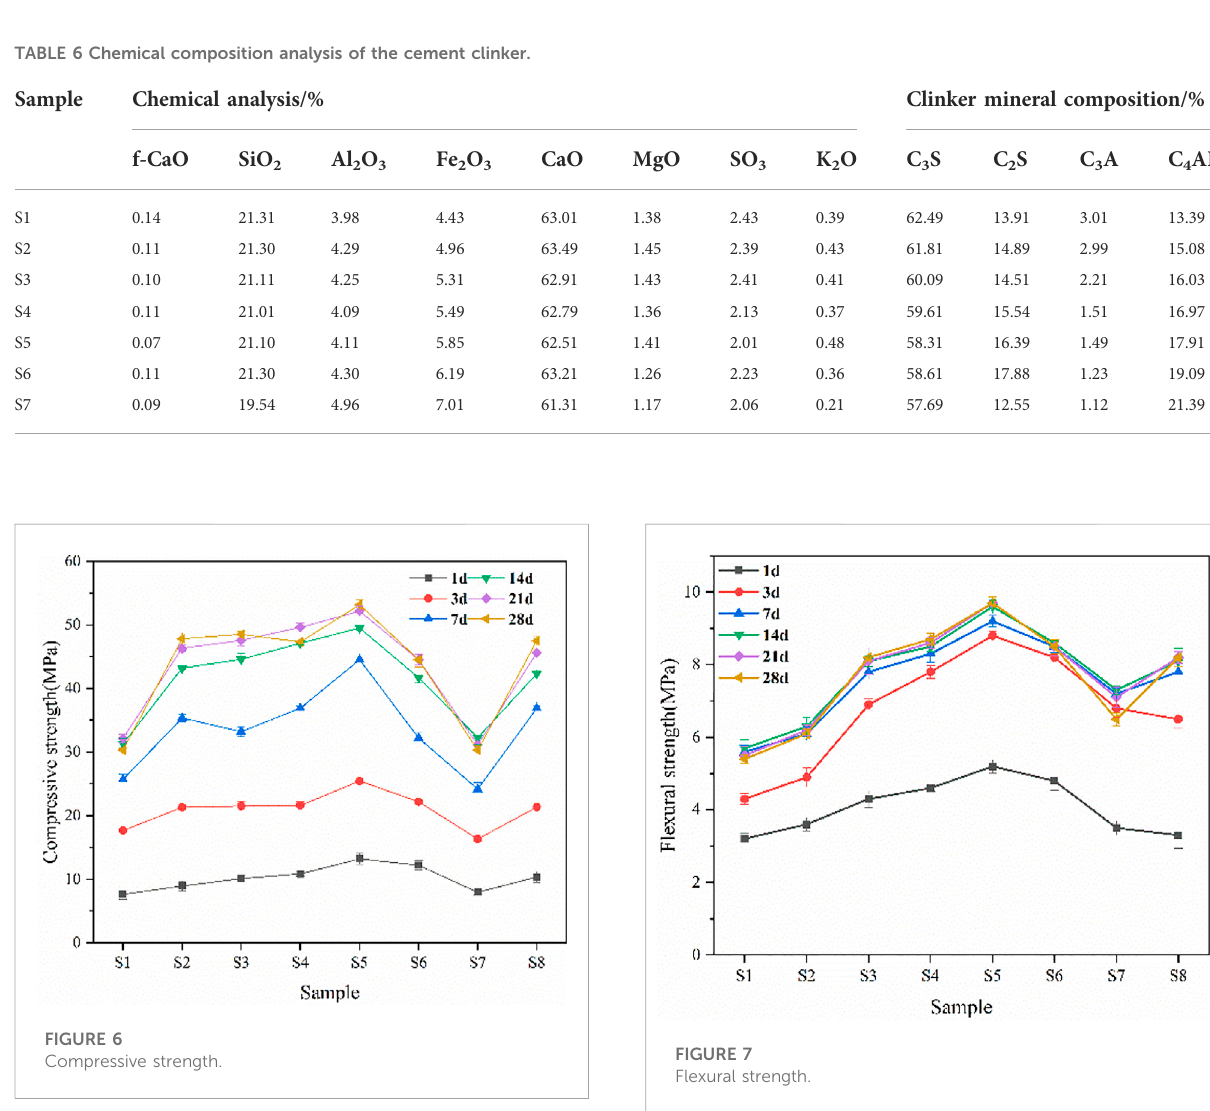
FIGURE 6 Compressive strength. FIGURE 7